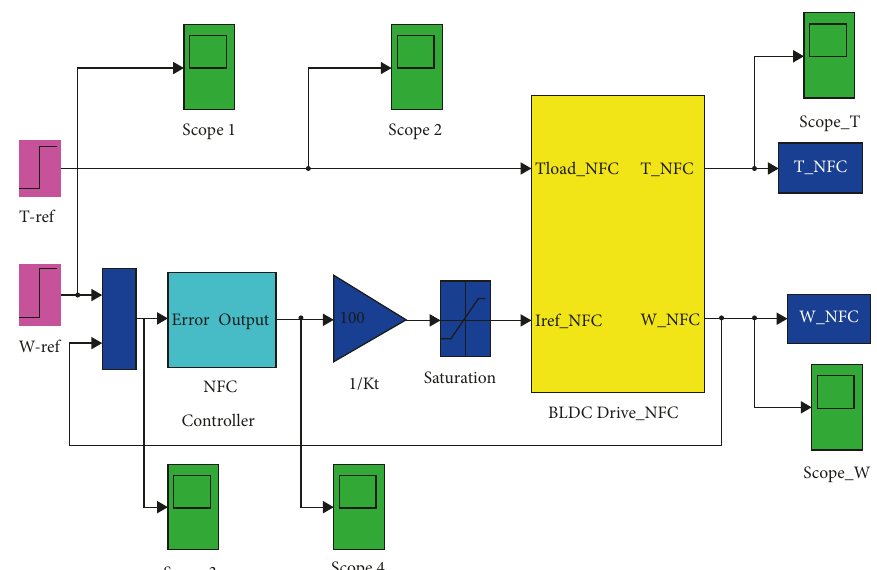
Figure 11: Block diagram of the system in Simulink